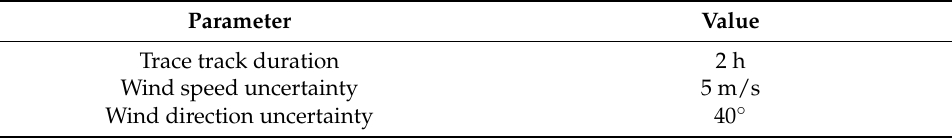
Table 1. Parameters applied for ship sector